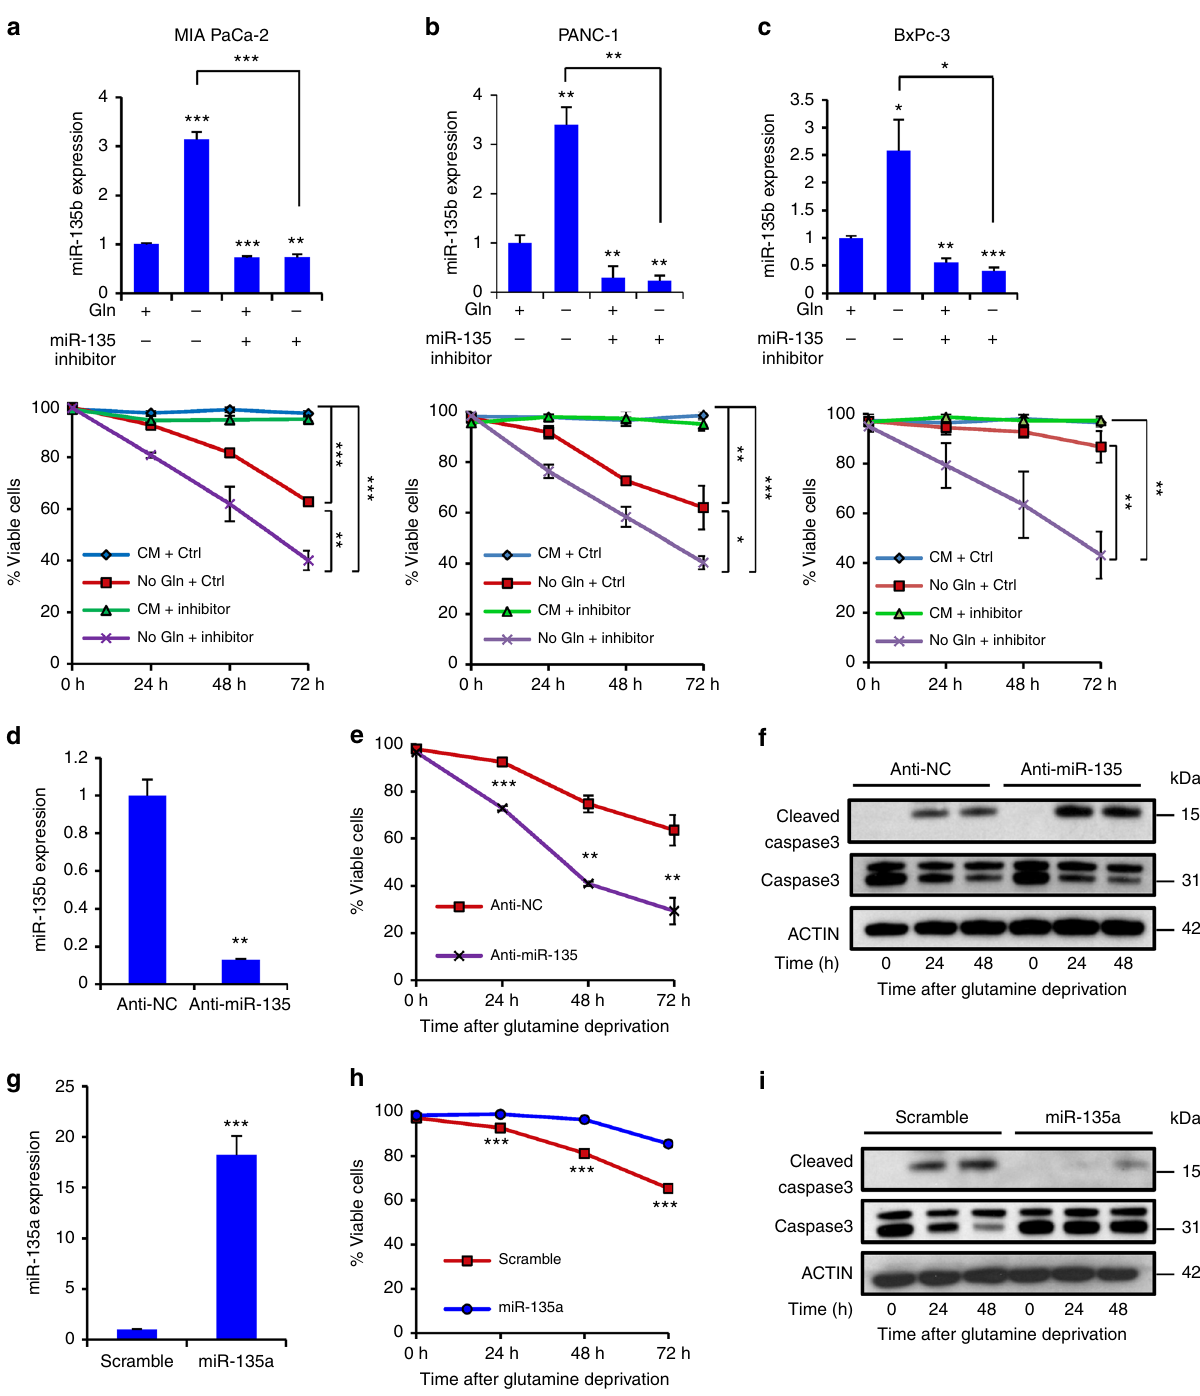
Fig. 3 miR-135 promotes PDAC survival upon glutamine deprivation. a – c MIA PaCa-2 cells ( a ), PANC-1 ( b ), and BxPc-3 ( c ) were transiently transfected with inhibitor control or hsa-miR-135 inhibitor. 48 h posttransfection, cells were cultured in glutamine-free medium. Relative miR-135b expression was assessed by qPCR. Cell viability was assessed by DAPI exclusion fl ow cytometry at the indicated time points. d MIA PaCa-2 cells were transfected with microRNA inhibitor control clone (anti-NC) or miR-135 inhibitor clone (anti-miR-135). miR-135b expression was assessed by qPCR. e MIA PaCa-2 cells expressing anti-NC or anti-miR-135 were cultured in glutamine-free medium. Cell viability was assessed by DAPI exclusion fl ow cytometry at the indicated time points. Cells were also lysed and immunoblotting was performed with indicated antibodies ( f ). Each value represents the mean ± SD in three independent experiments. * p < 0.05, ** p < 0.01, *** p < 0.001, Student ’ s t test. g MIA PaCa-2 cells were transfected with microRNA scramble control clone or miR-135a precursor clone. miR-135a relative expression was assessed by qPCR. Each value represents the mean ± SD in four independent experiments. DAPI exclusion fl ow cytometry at the indicated time points. Each value represents the mean ± SD in three independent experiments. *** p < 0.001, Student ’ s t test. i Cells were also lysed and immunoblotting was performed with indicated antibodies (CM: complete medium; No Gln: glutamine-free medium). PDAC: pancreatic ductal